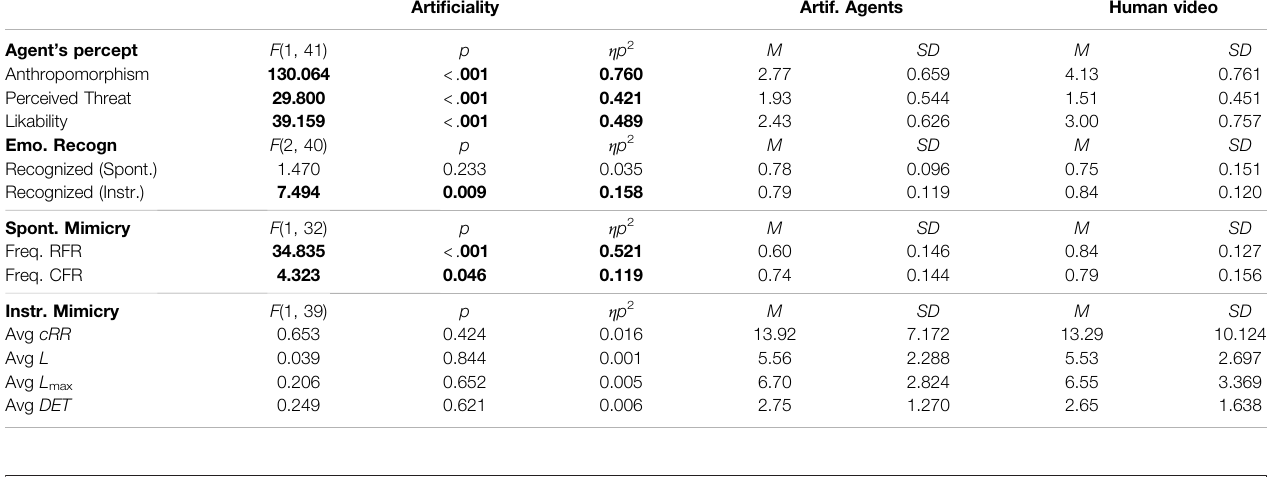
TABLE 5 | Results of 2 x 3 ANOVAs and Descriptive Statistics. The signi fi cant results are displayed in bold. The Mean ( M ) and standard deviation ( SD ) of all dependent variables are divided per Arti fi cial and Human Agents. Arti fi ciality